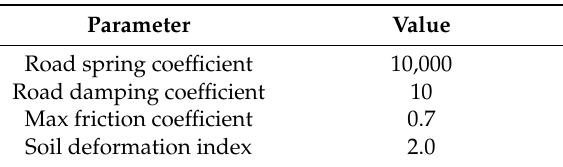
Table 6. Hard pavement parameters.